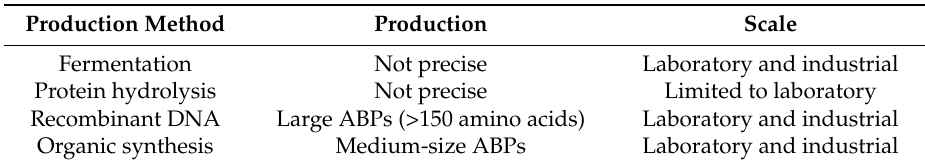
Table 4. Industrial production of ABPs